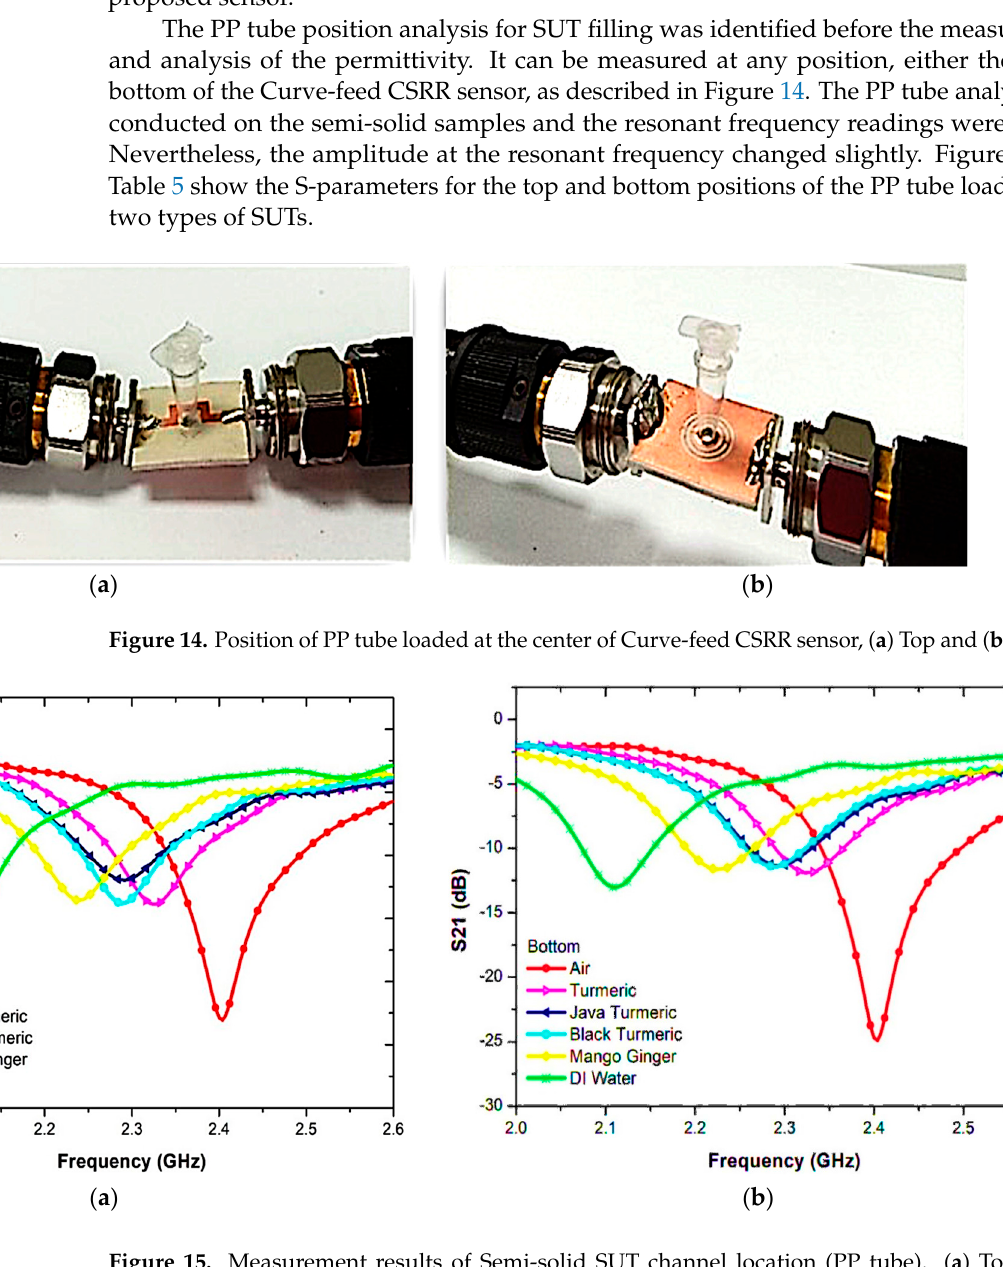
Figure 15. Measurement results of Semi-solid SUT channel location (PP tube). ( a ) Top sensor. ( b ) Bottom sensor. Table 5. Comparative measurement results of semi-solid channel location (PP tube) for top and bottom triple-rings CSRR sensor .